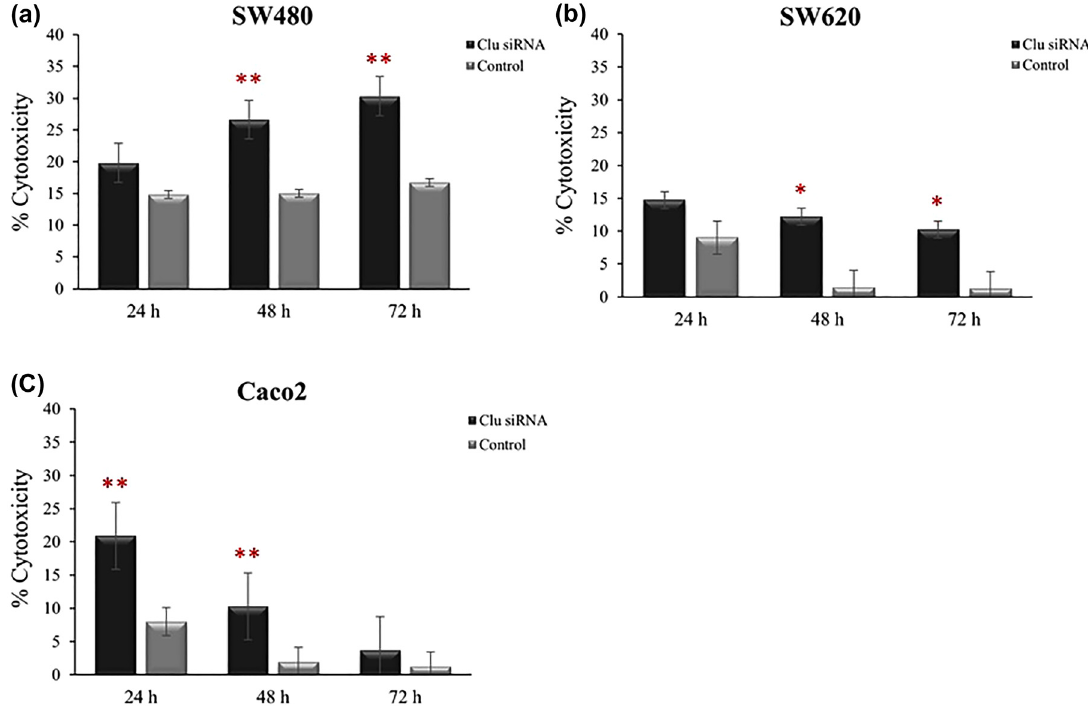
Figure 2: The percentage of cytotoxicity (%) in clusterin-silenced (a) SW480, (b) SW620, and (c) Caco2. Thecytotoxiclevelof clusterin-silencedcolorectalcancercells (ClusiRNA)comparedtothecytotoxiclevelofnon-clusterin-silencedcolorectal cancercells(control)at24,48,and72h.Threereplicationswerecarriedoutinatleasttwoindependentexperiments.Thedataarerepresented as the mean ± SD; * p<0.05 and **